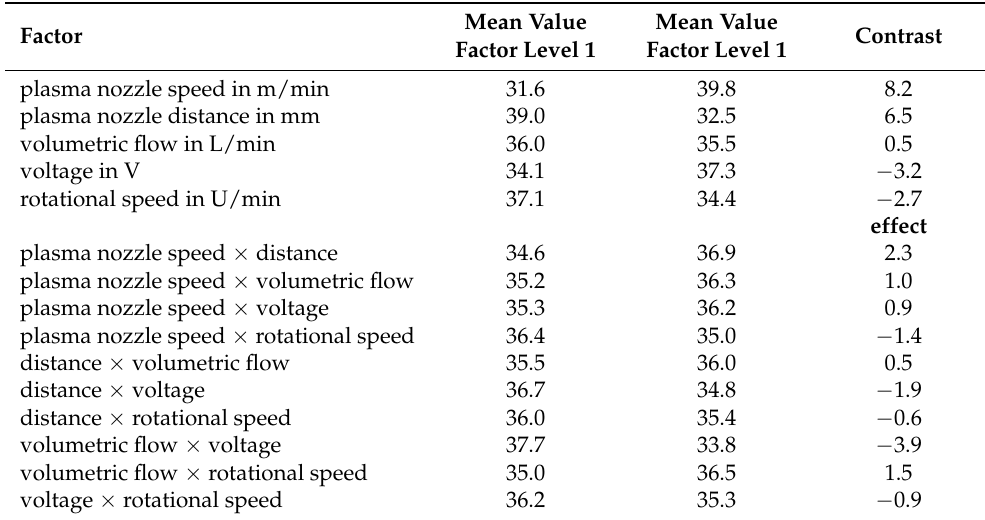
Figure 3. The resulting 2-level fractional factorial contact angle measurements for specimen with different plasma treatment (sample designations as seen in Table 2). Table 3. Interpretation of the 2-level fractional factorial design using the contrast